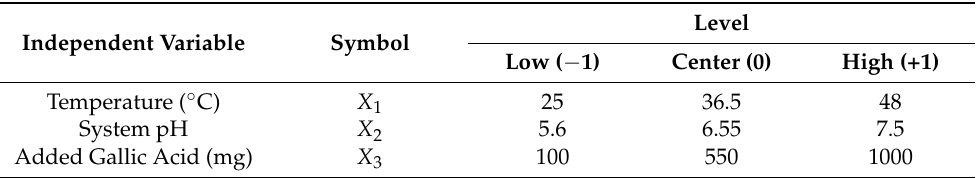
Table 1. RSM design using the uncoded and coded levels of independent variables for the preparation of individual calcium oxalate hydrate phase (dependent variable;